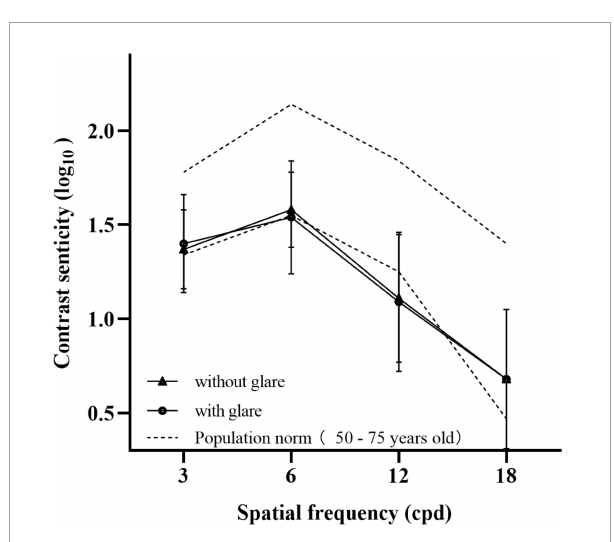
FIGURE2 Mean value of contrast sensitivity without glare (triangle) and contrast sensitivity with glare (circle) at spatial frequencies of 3, 6, 12, and 18 cpd. The results were compared with the normal value defined previously (dotted